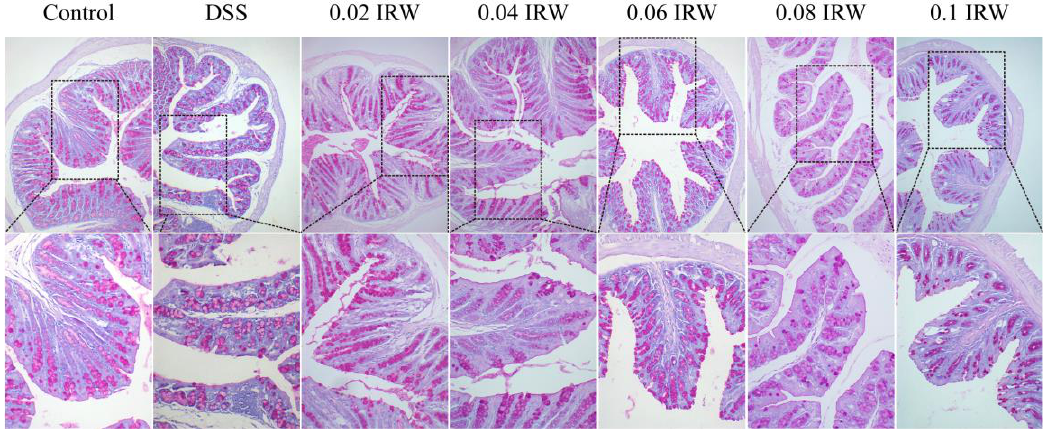
Figure 3. Pathological section of PAS staining (black box represents magnified area).